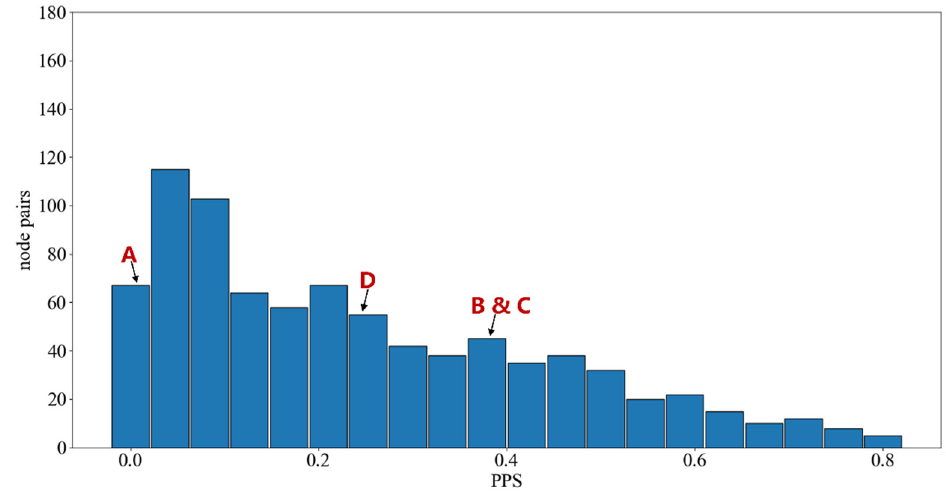
Figure 15 . The Statistical Diagram of PPS of 180 nodes (A, B, C and D respectively corresponds to the four conditions in Figure 14.).